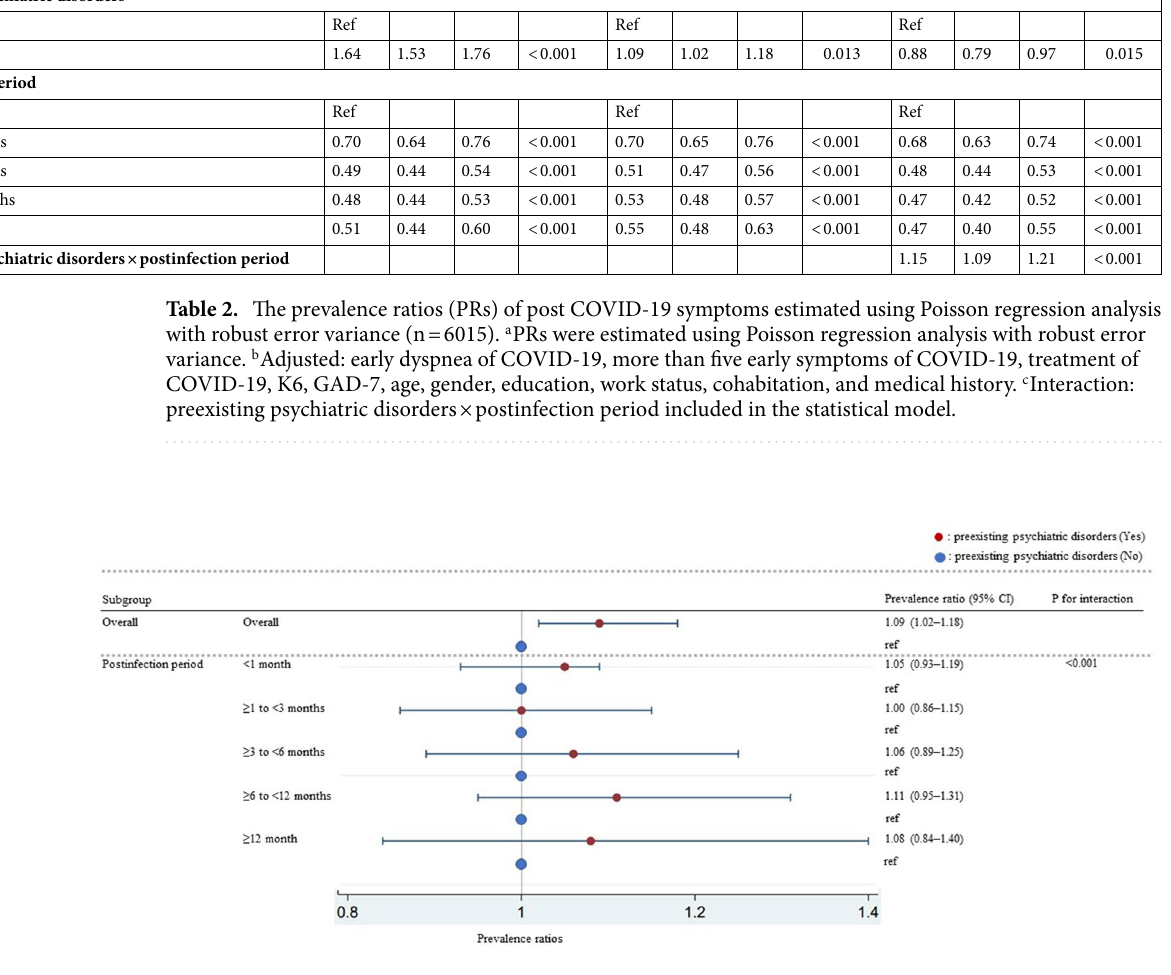
Figure 2. Result of subgroup analyses by postinfection periods (n =